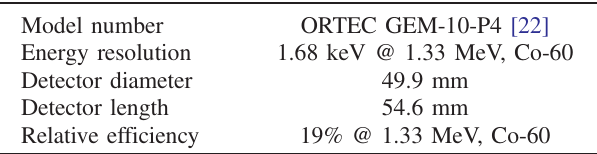
TABLE III. Specifications for the HPGe detector at UIUC.